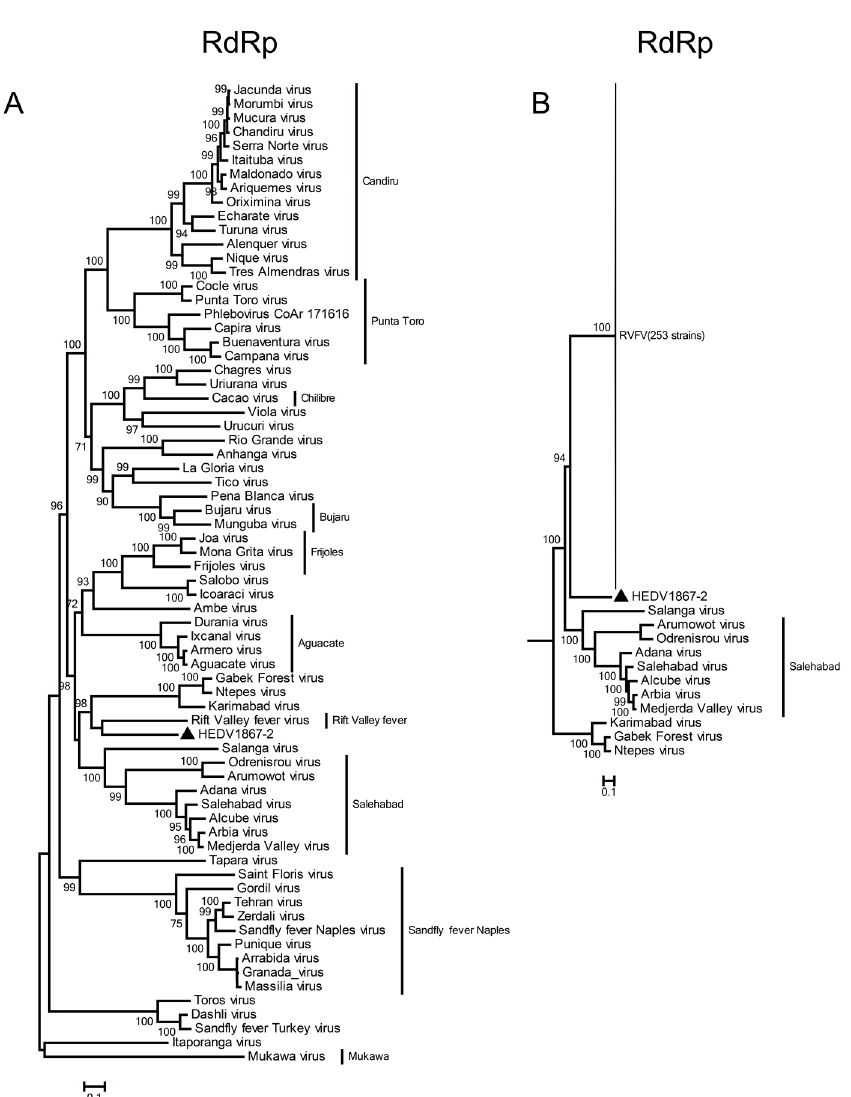
Figure 2. The evolutionary relationship between the RdRp amino acid sequences of HEDV1867- 2, ( A ) 59 species of phleboviruses and ( B ) 253 strains representative of the RVFV diversity. The HEDV1867-2 virus identified in this study was marked with black triangles. The trees were recon- structed with maximum likelihood approach.